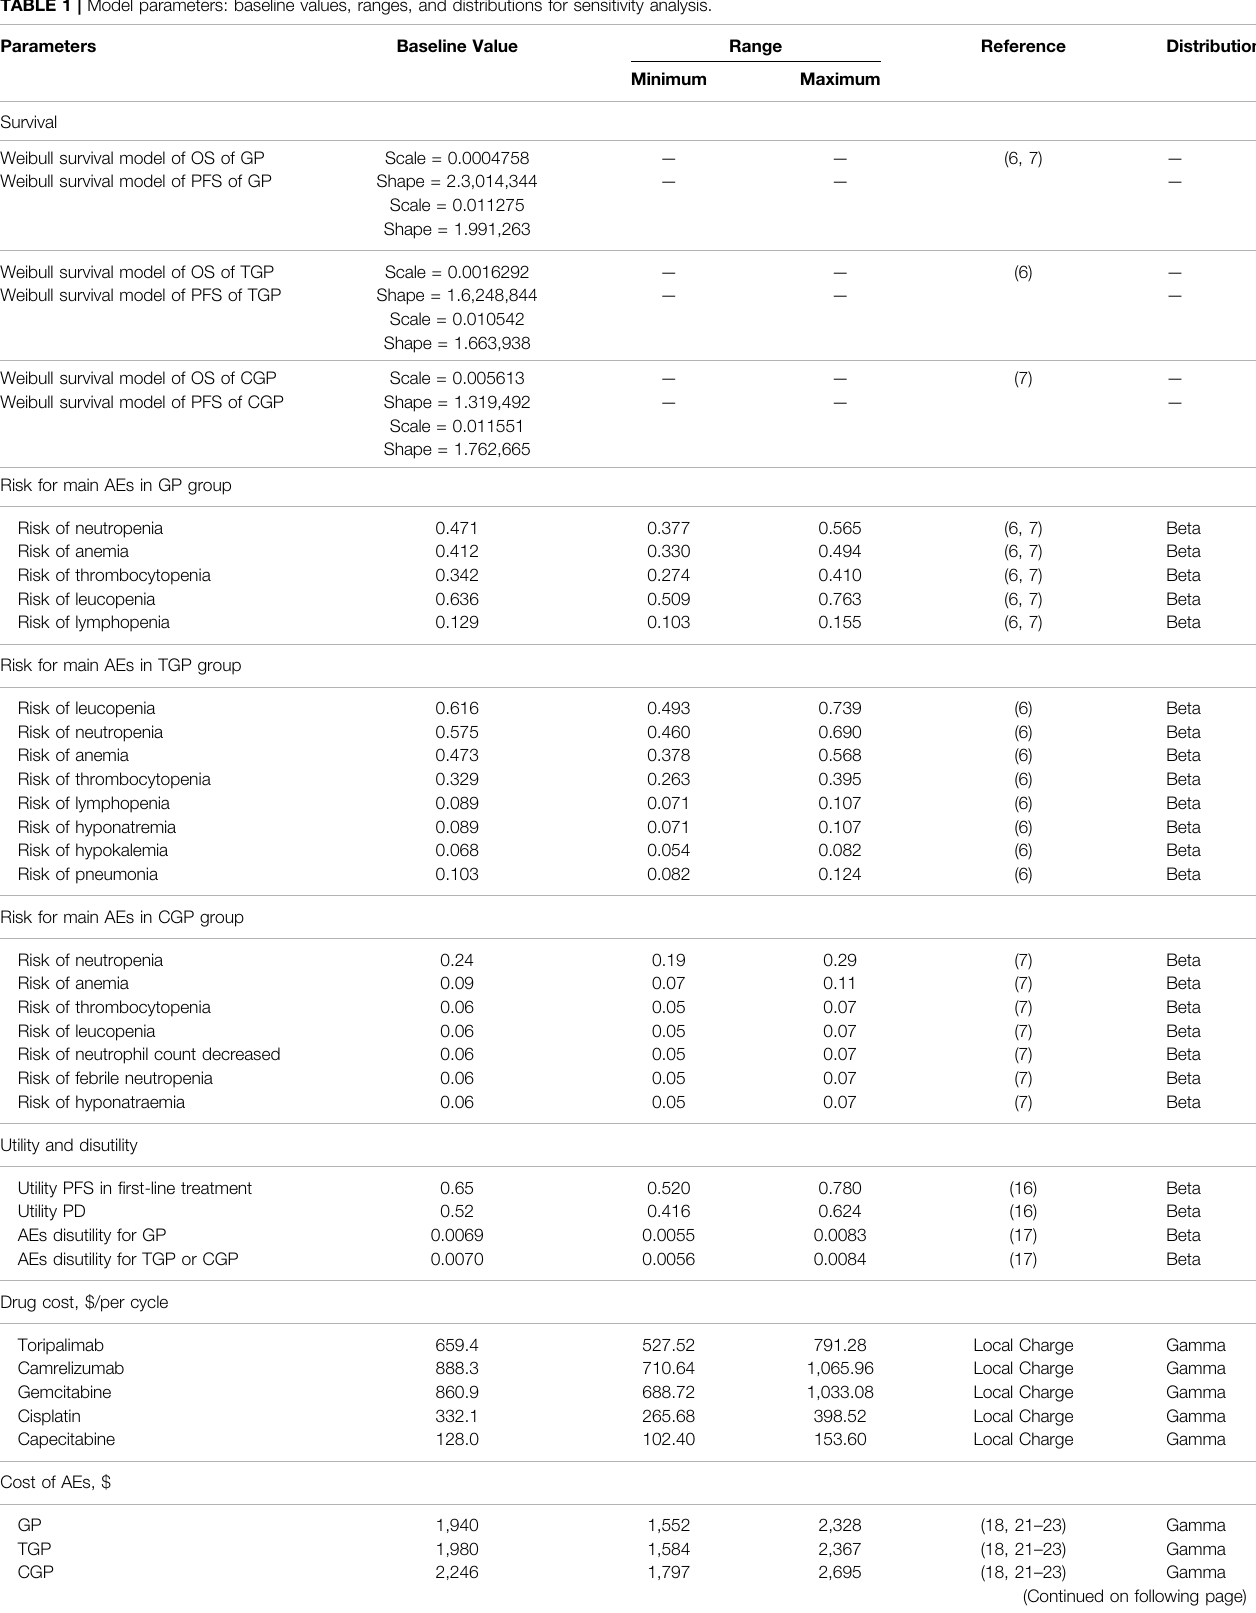
TABLE 1 | Model parameters: baseline values, ranges, and distributions for sensitivity